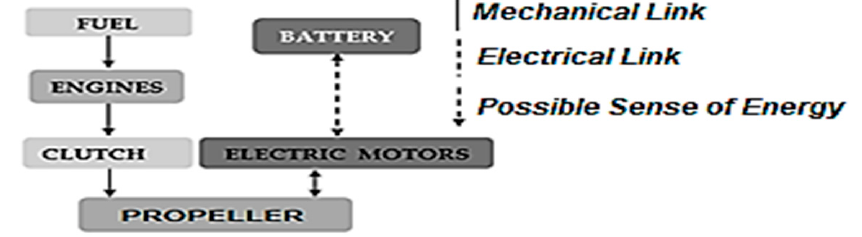
Figure 4. Example of parallel hybrid propulsion configuration.